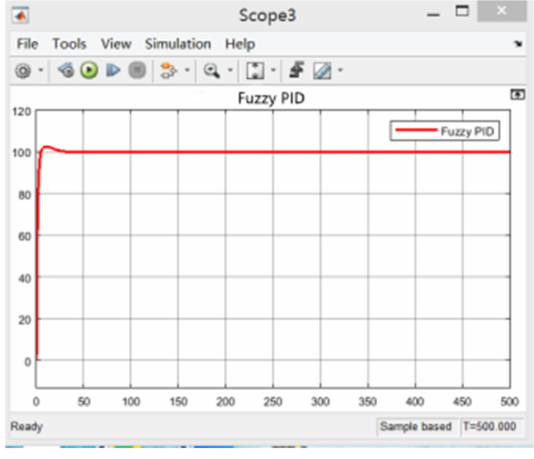
Figure 15. Response